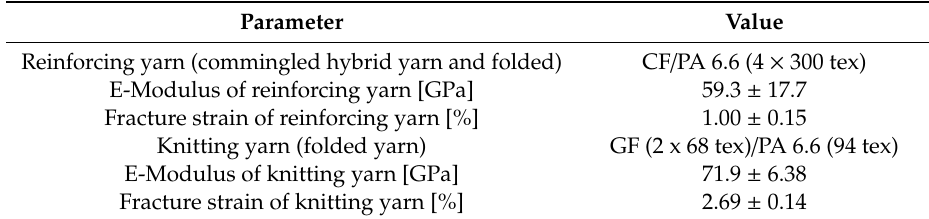
Table 1. Yarn properties.